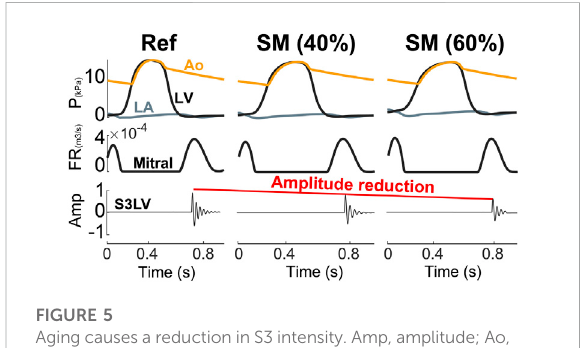
FIGURE 5 Aging causes a reduction in S3 intensity. Amp, amplitude;